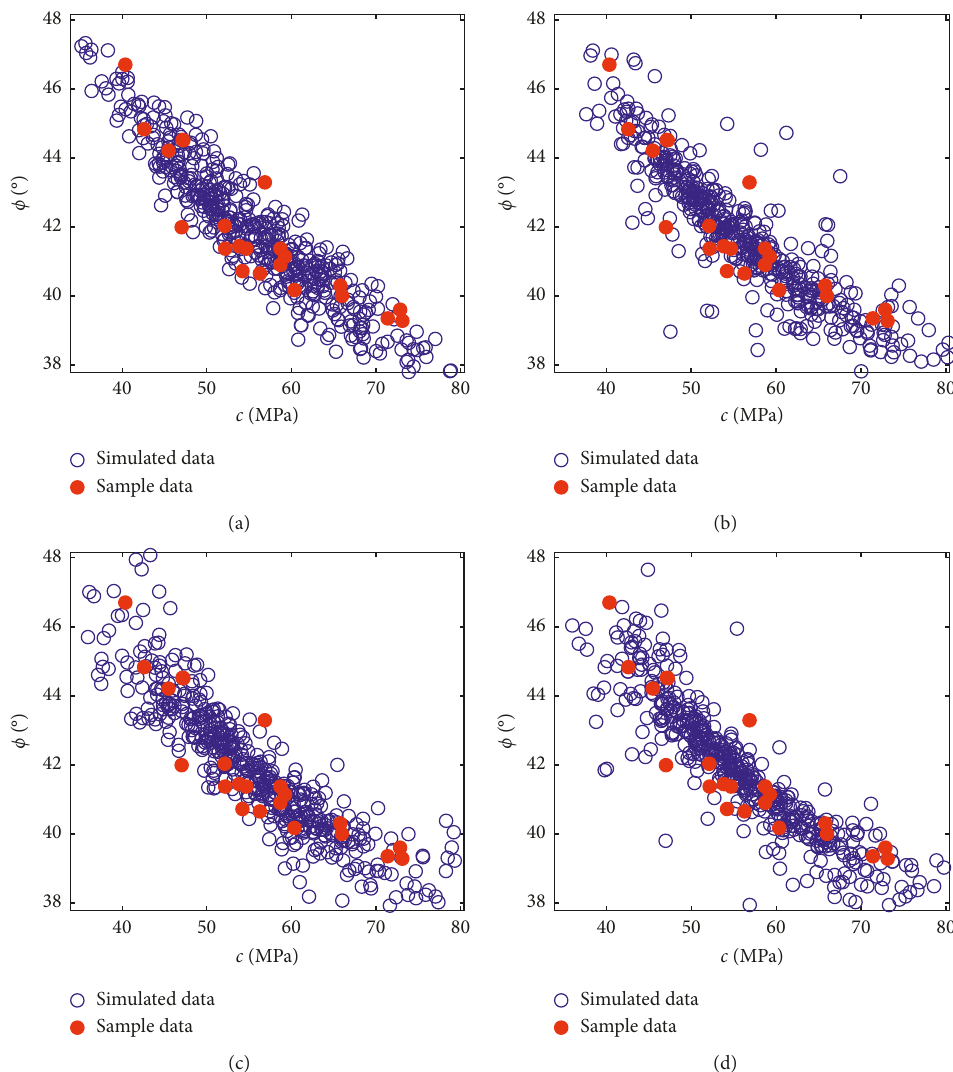
Figure 11: Scatter plots of equivalent samples generated by different copulas coupling Lognormal margins. (a) Gaussian copula. (b) Plackett copula. (c) Frank copula. (d) No. 16